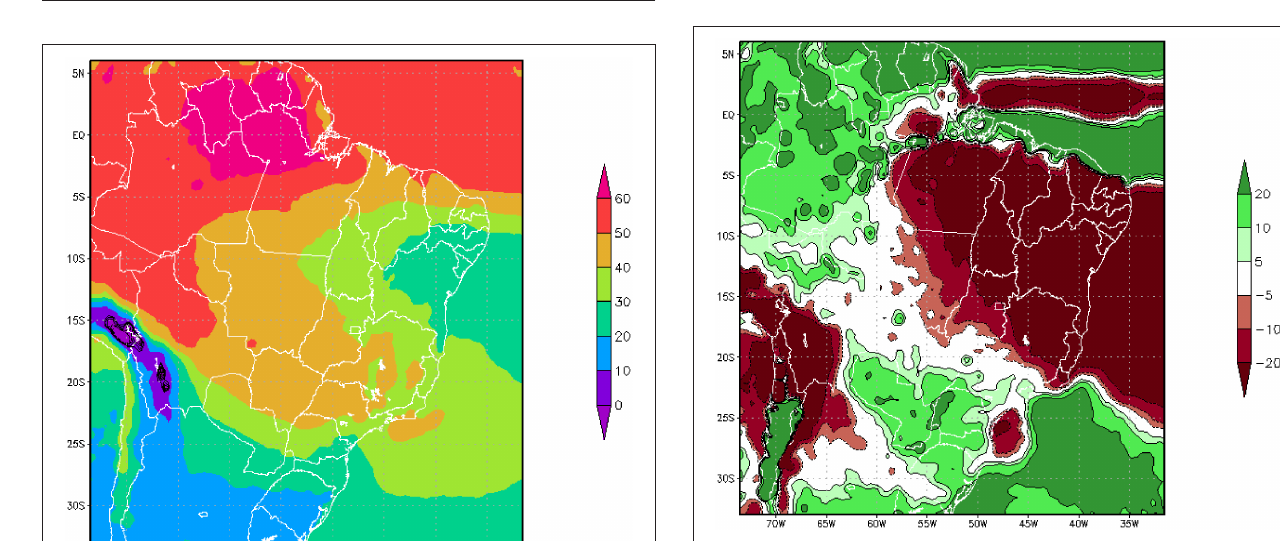
FIGURE 8 | Same as Figure 7, but for precipitation changes (%) on the period